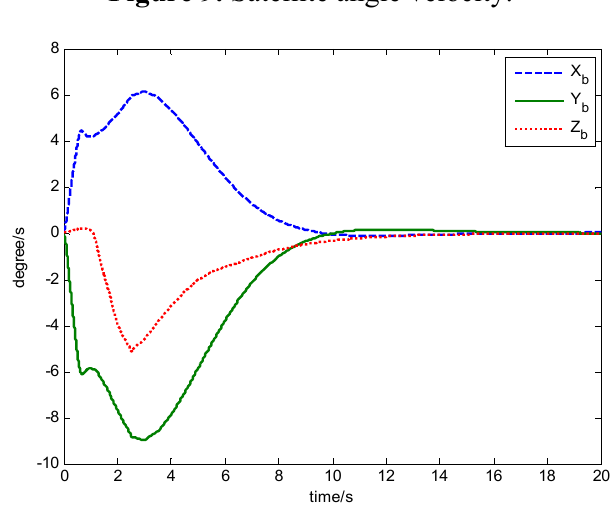
Figure 9. Satellite angle velocity.